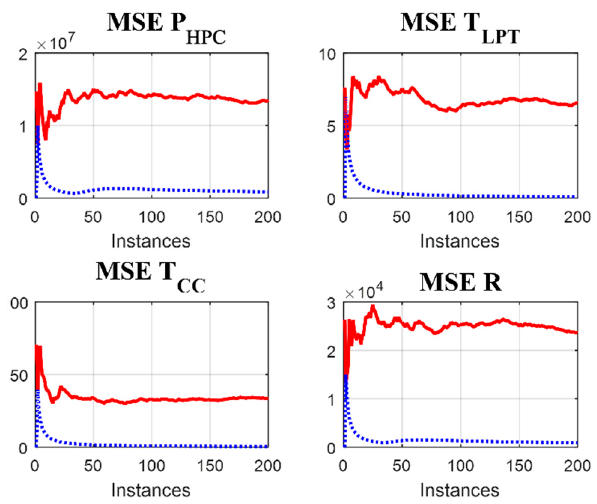
Figure 7. Initial noisy (observed) GTE variables in red color and Filtered (reconstructed) GTE variables in blue color.